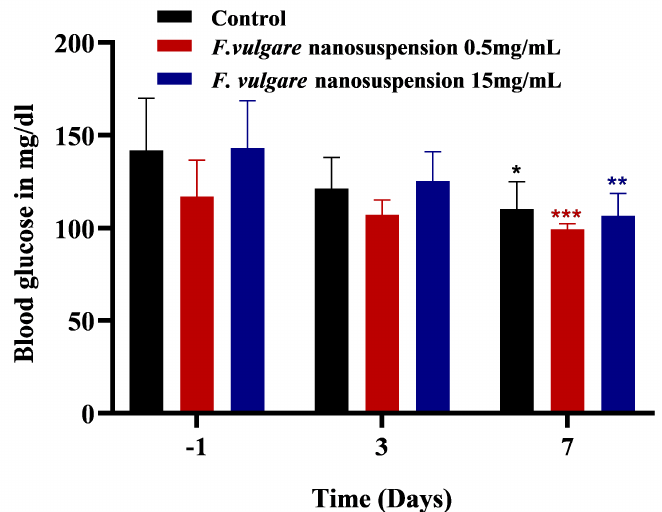
Figure 5. Effects of F. vulgare on blood glucose level. *, **, *** represents the significance of re- sults/data.